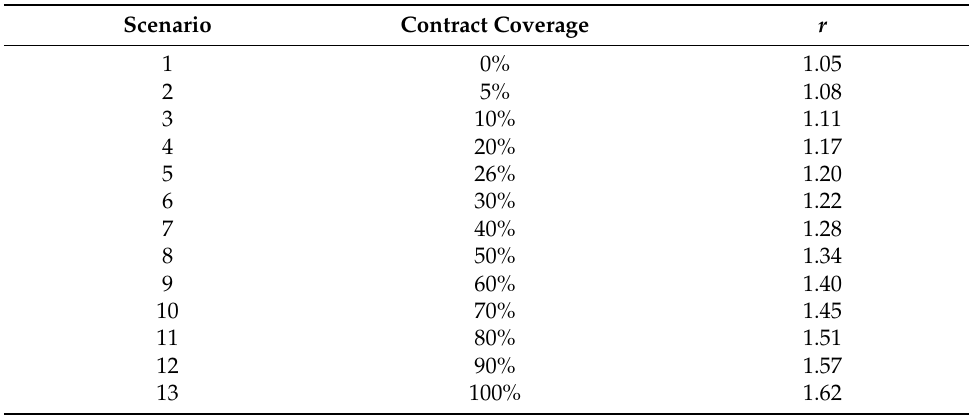
Figure 24. Relationship between contract coverage and market power. Table 9. Contract coverage and